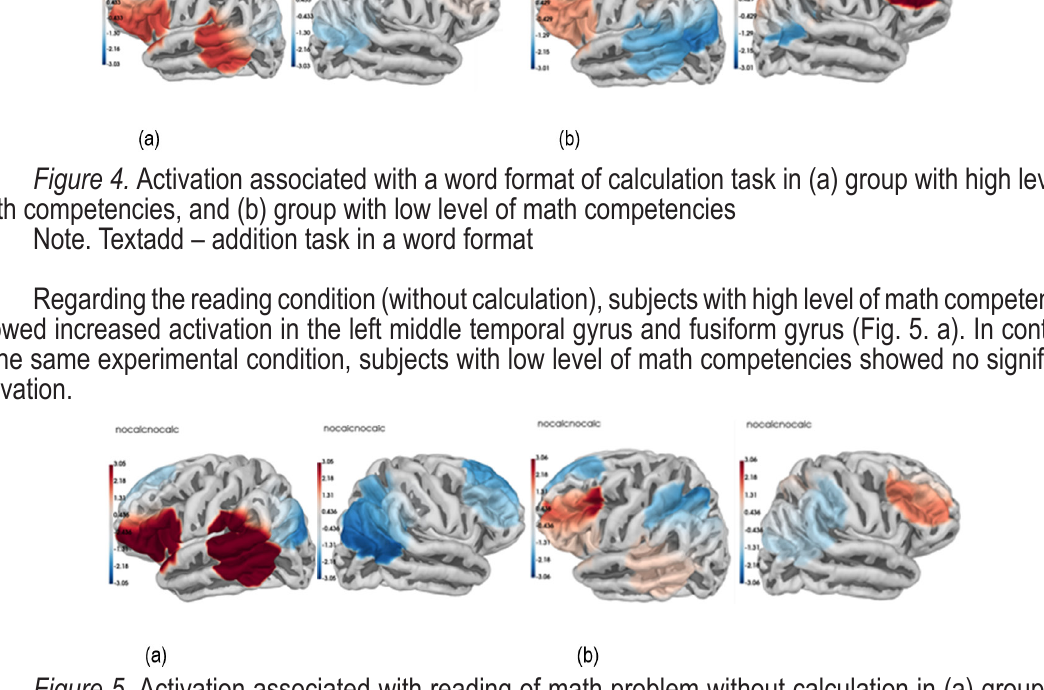
Figure 5. Activation associated with reading of math problem without calculation in (a) group with high level of math competencies, and (b) group with low level of math competencies Note. Nocalc –